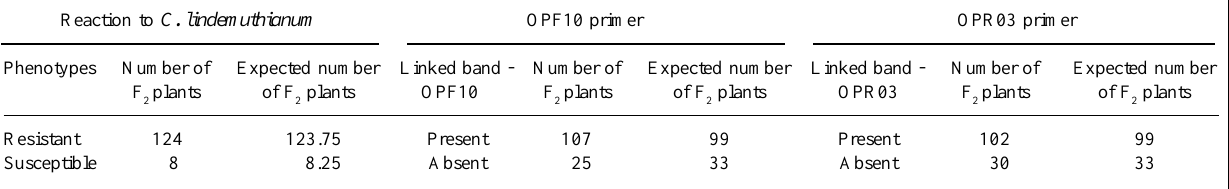
Table IV - Number of F bean plants with resistant or susceptible phenotypes and occurrence of linked bands 2 generated by the primers OPF10 and OPR03, for the cross P24 x Ouro. Reaction to C. lindemuthianum